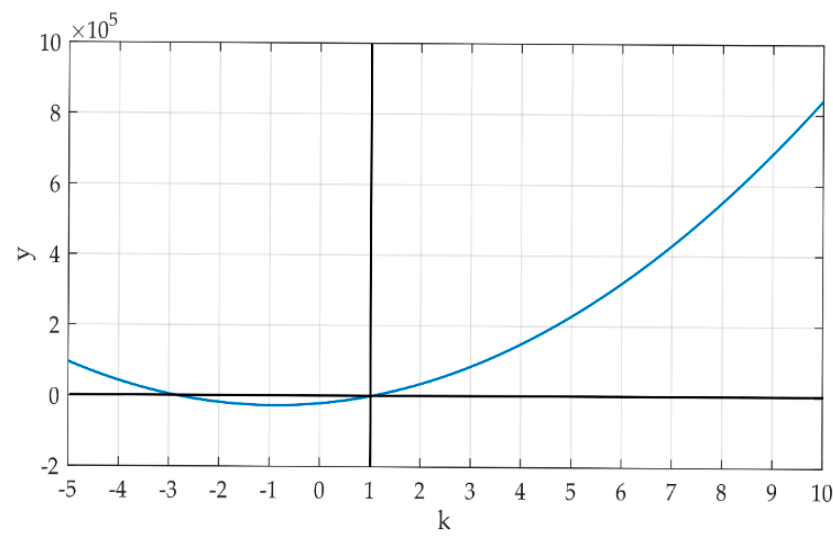
Figure A1. The function image of y = 7300 k 2 + 13264 k − 20564. Figure B1. The function image of y = 7300𝑘 Figure B1. The function image of y = 7300𝑘 (cid:2870) + 13264𝑘 − 20564 .